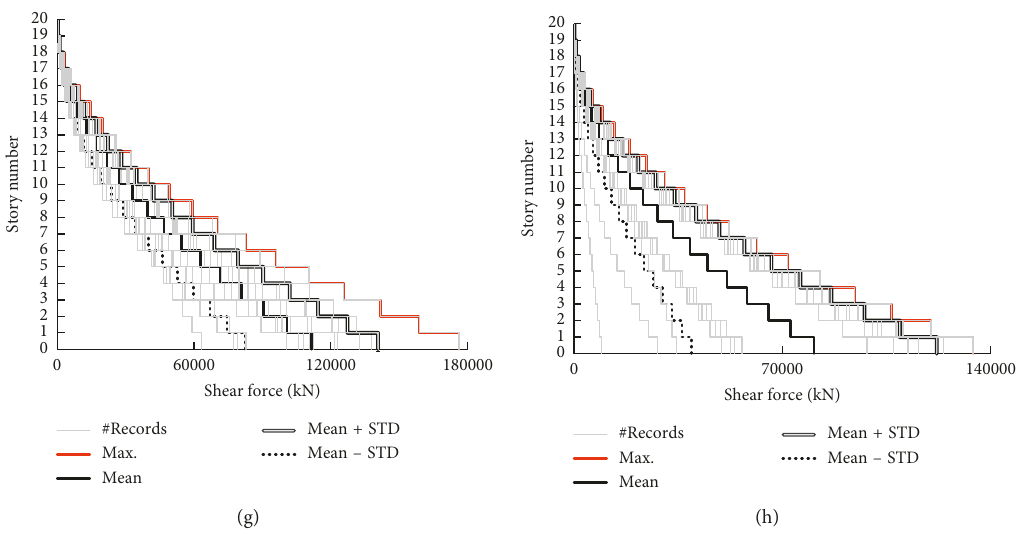
Figure 9: Shear force in 3-, 5-, 8-, and 20-story building subjected to near- (a, c, e, g) and far-field (b, d, f, h) earthquakes. Table 7: Comparison of shear force in 3-, 5-, 8-, and 20-story buildings subjected to near- and far-field earthquakes. No. of